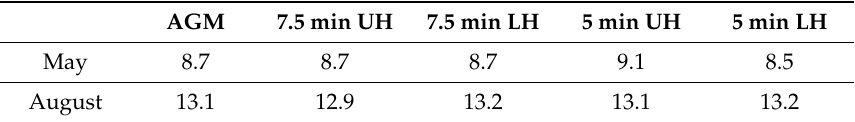
Table 1. Cumulative loss of total ammoniacal nitrogen (TAN) from field-applied slurry in percentage (%) of total applied TAN for AGM with simultaneous and continuous measurements at two height and simulated discontinuous measurements. UH and LH refer to starting simulation in upper or lower height, respectively.